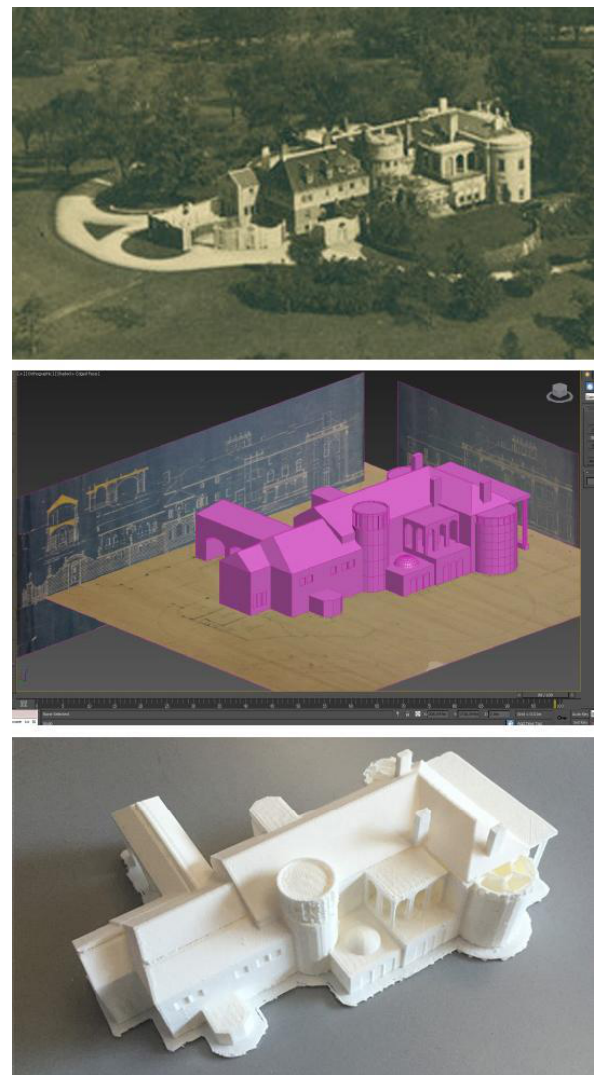
Figure 7. Process of 3D modeling Anderson mansion from referencing measured archival drawings and